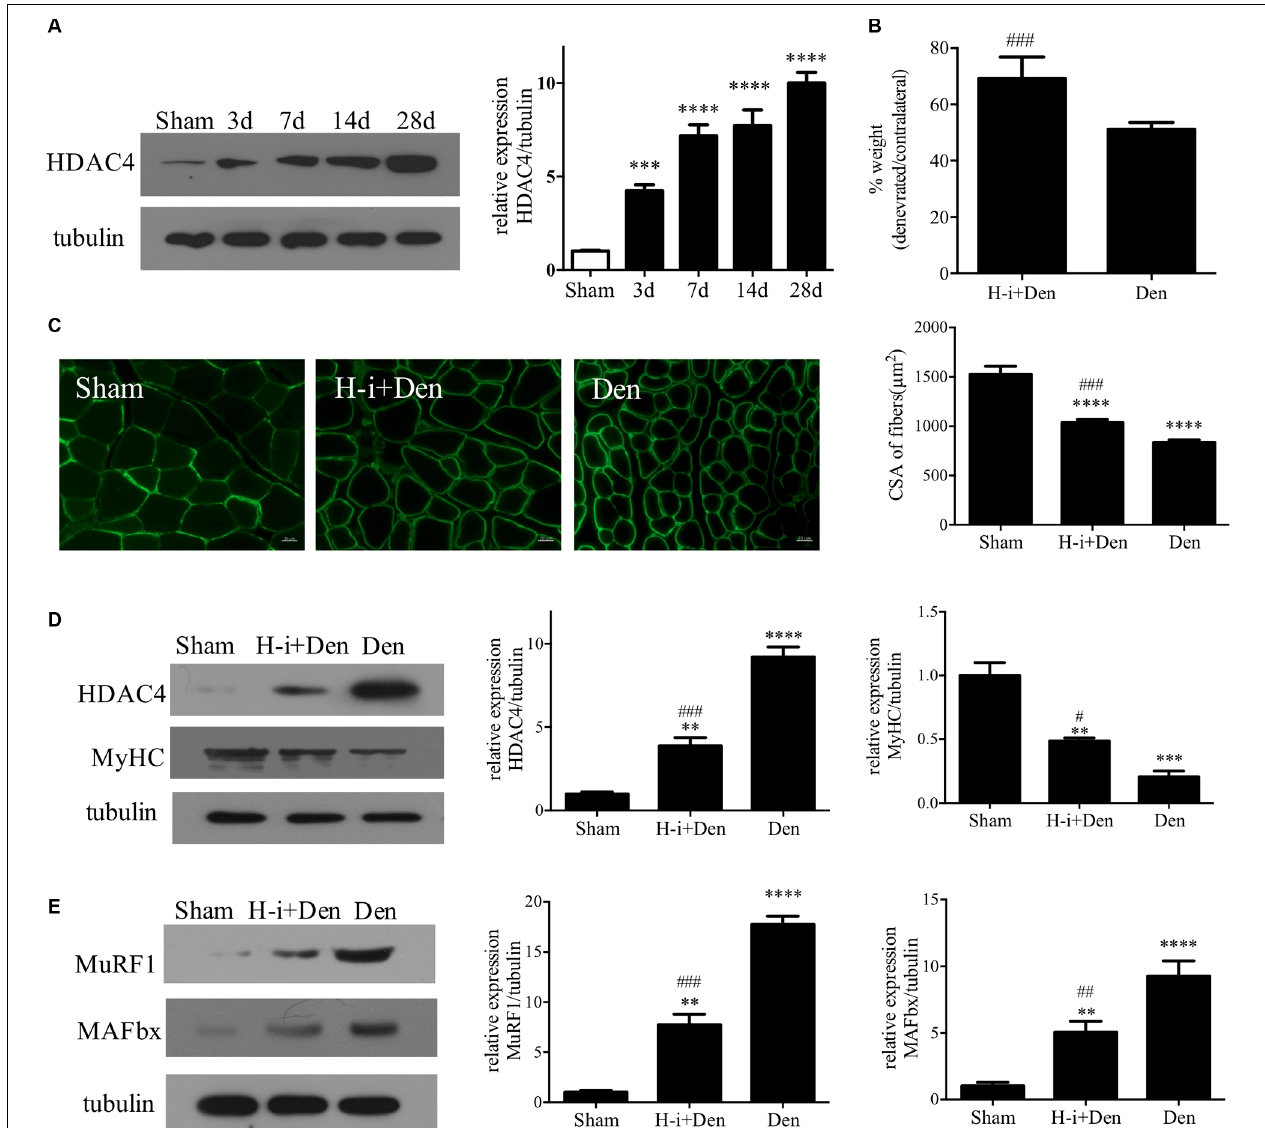
FIGURE 1 | HDAC4 inhibition diminished denervation-induced muscle atrophy. (A) The expression of HDAC4 in tibialis anterior muscle at different time points after denervation was detected by Western blot. (B) Wet weight ratio of muscle. Sciatic nerve transection model was prepared after injection of HDAC4-shRNA lentivirus (H-i+Den) or empty vector virus (Den) into the tibialis anterior muscle of mice. The empty vector virus was injected into muscles from the sham group (Sham). Muscle wet weight ratio was measured after 14 days. (C) The muscle fiber cross section area (CSA) was analyzed by laminin staining. (D) The expression levels of HDAC4 and MyHC were detected by Western blot. (E) The expression levels of muscle specific E3 ubiquitin ligase (MuRF1 and MAFbx) were detected. ** P < 0.01, ∗∗∗ P < 0.001, ∗∗∗∗ P < 0.0001 vs. sham group. # P < 0.05, ## P < 0.01, ### P < 0.001 vs. denervated